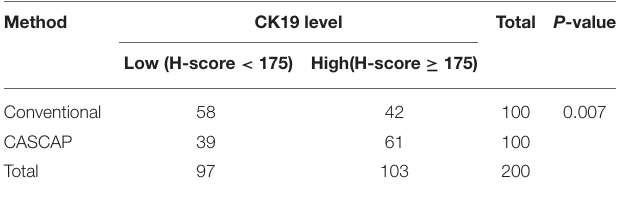
TABLE 3 | Association of CK19 staining between new (CASCAP) and conventional (CV)